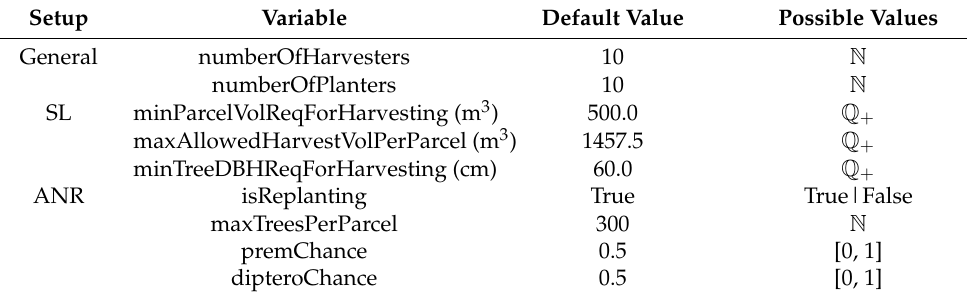
Table 3. Parameters for setting a simulation experiment.